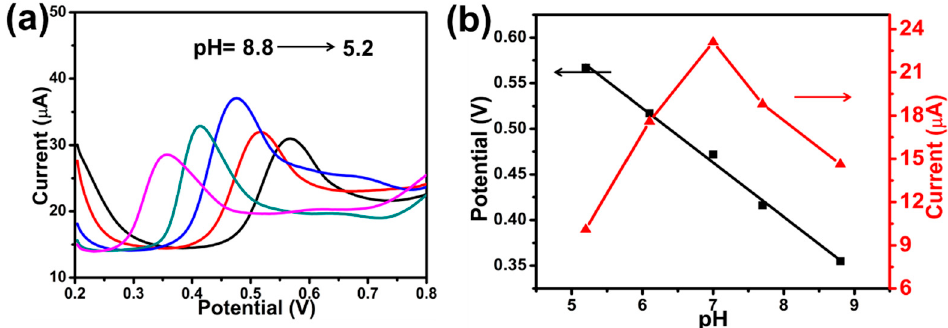
Figure 4. DPVs of MI-Au-MoO 3 / r GO electrode in 0.1 M phosphate buffer with different pH ( a ). Effects of pH value on the potential (black line) and peak current (red line) ( b ). [BPA] = 0.1 mM.